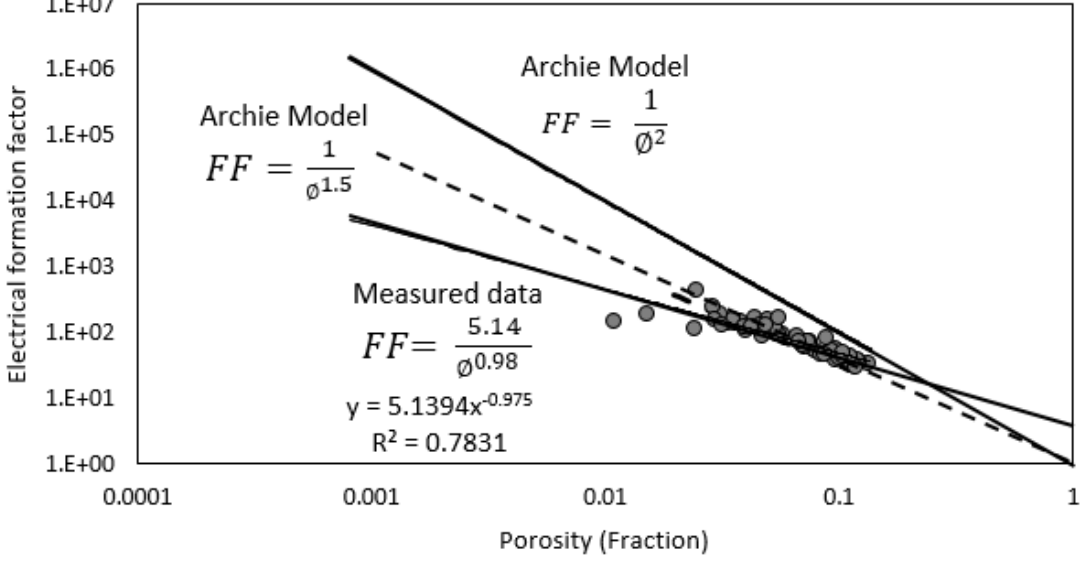
Figure 24. Formation resistivity factor versus porosity for 56 subsamples. Table 4. Tortuosity range for 56 subsamples using different electrical tortuosity models.